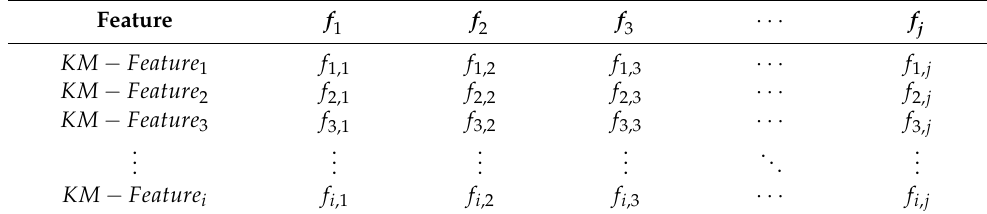
Table 1. Examples of keystroke mouse dynamics